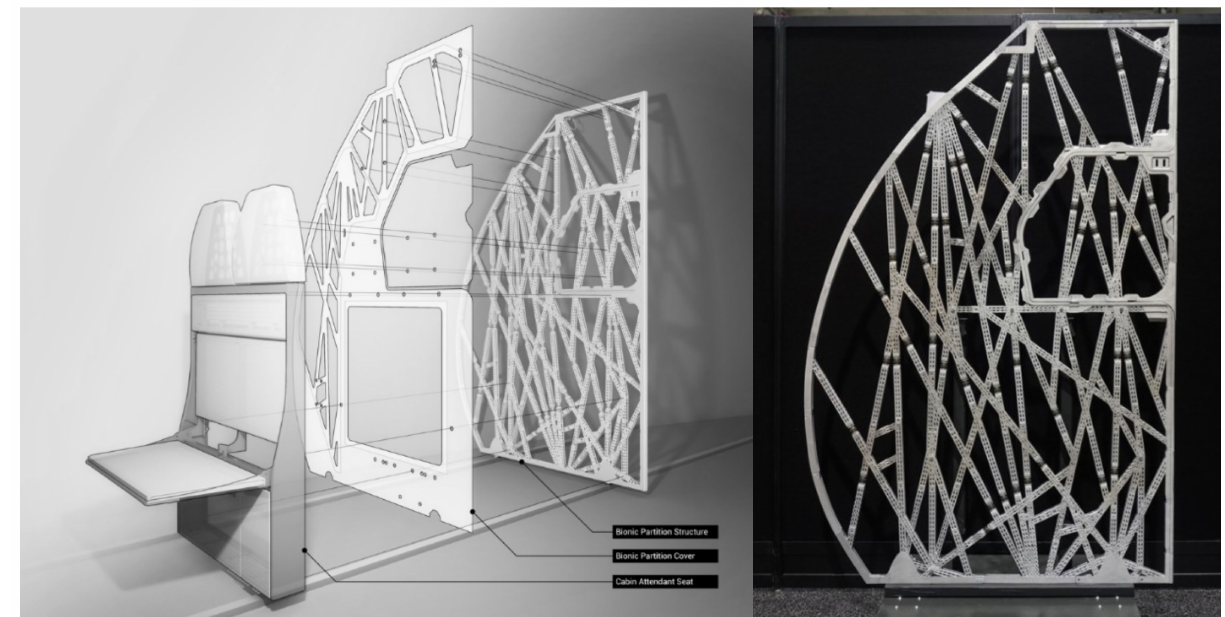
Figure 1. Airbus lattice structure of a partition wall made of AlMgSc alloy and produced by L-PBF [33] (image courtesy of The Living).